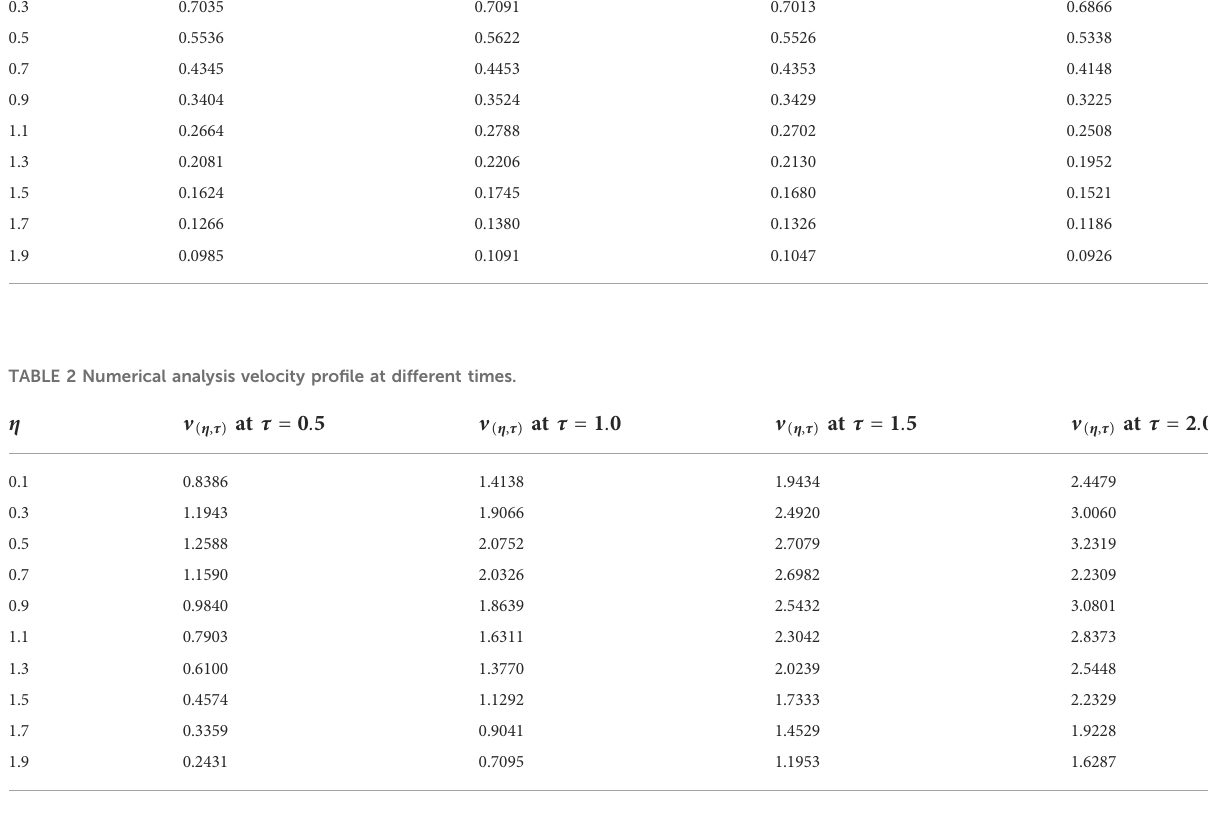
TABLE 1 Numerical analysis of the temperature fi eld at different times. η T ( η at τ (cid:3) 0 . 5 , τ )